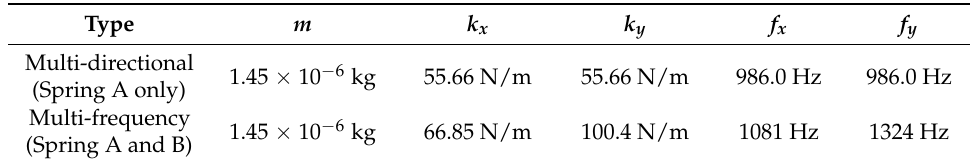
Table 3. Parameters for each type of developed energy